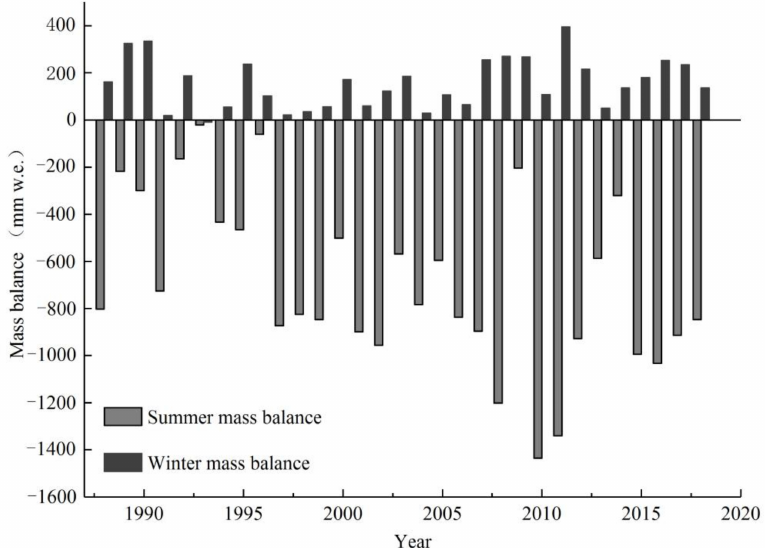
Figure 3. Seasonal variation of mass balance of Urumqi Glacier